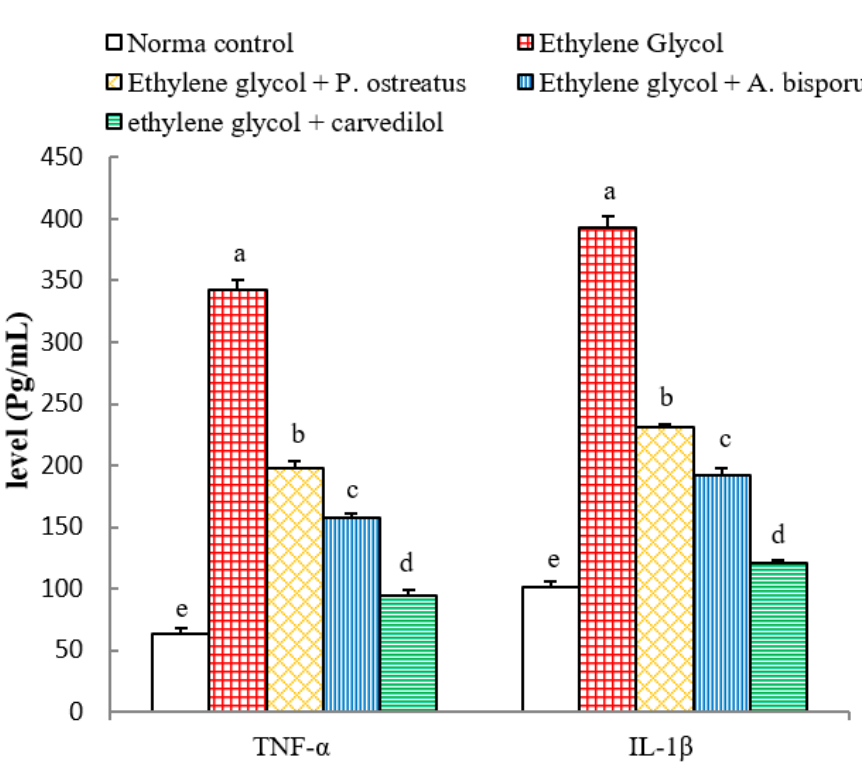
Figure 11. Effect of P. ostreatus and A. bisporus aqueous extracts and carvedilol on serum TNF- α and IL-1 β levels in ethylene glycol-administered rats. Means which share the same letter(s) are not significantly different. Biomolecules 2020 , 9 , x